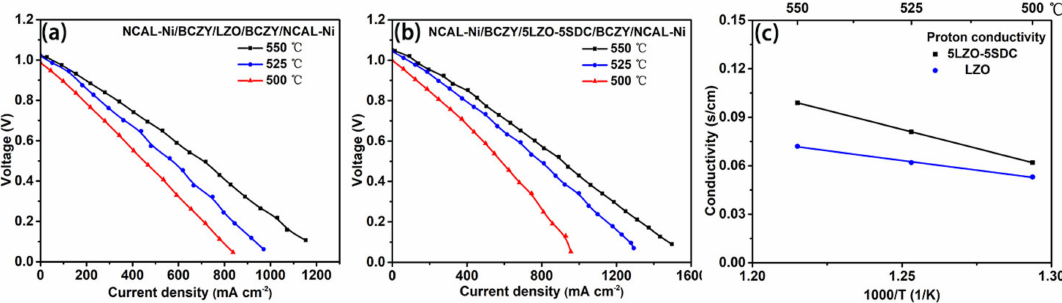
Figure 7. I-V polarization curve of the two O 2 − /e − filtering fuel cells based on ( a ) LZO and ( b ) 5LZO-5SDC, and ( c ) the corresponding proton conduction estimated based on ( a , b ).